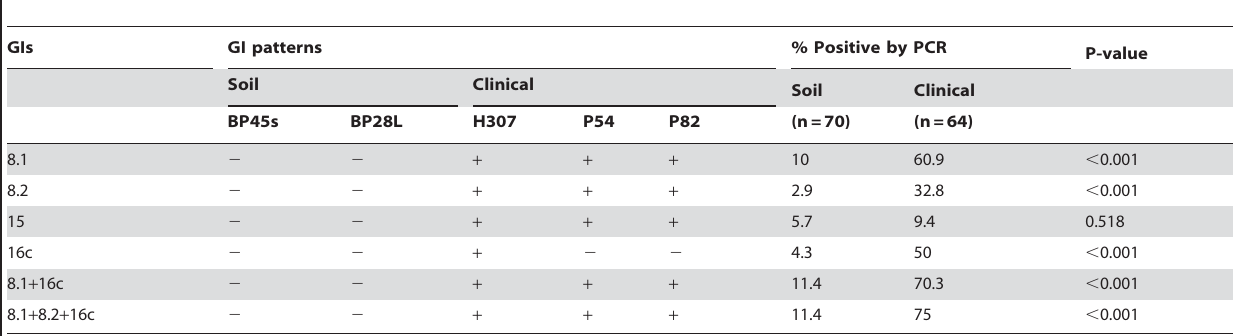
Table 3. PCR detection of four GIs in 70 soil and 64 clinical B. pseudomallei isolates.